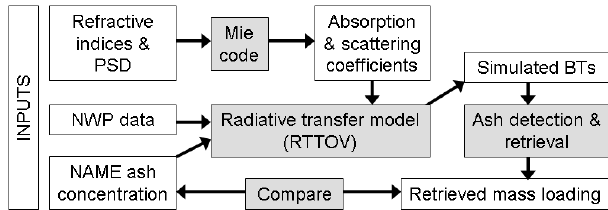
Figure 8. Schematic of the method used to compare input ash mass concentration and retrieved ash mass loading. The white boxes con- tain data and the grey boxes represent